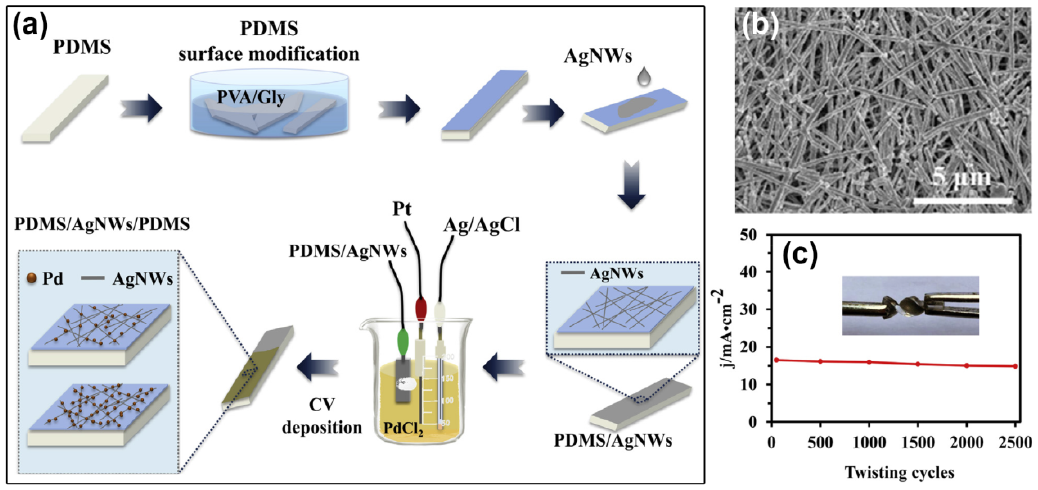
Figure 8. ( a ) Schematic illustration of the preparation process for Pd / Ag NWs / PDMS flexible electrodes. ( b ) SEM image of the Pd / AgNWs / PDMS electrodes deposited by cyclic voltammetry with an optimal cycle number of 25. ( c ) The peak specific oxidation current density (recorded in 0.1 M KOH and 1.0 M ethanol solution at 0.55 V) of the CV curve as a function of twisting cycles (with a fixed twisting angle of 720 degree) for the flexible Pd / Ag NWs / PDMS electrodes. The inset corresponds to the enlarged view of the twisting setup. Reproduced with permission from [25]. Copyright 2019, Hydrogen